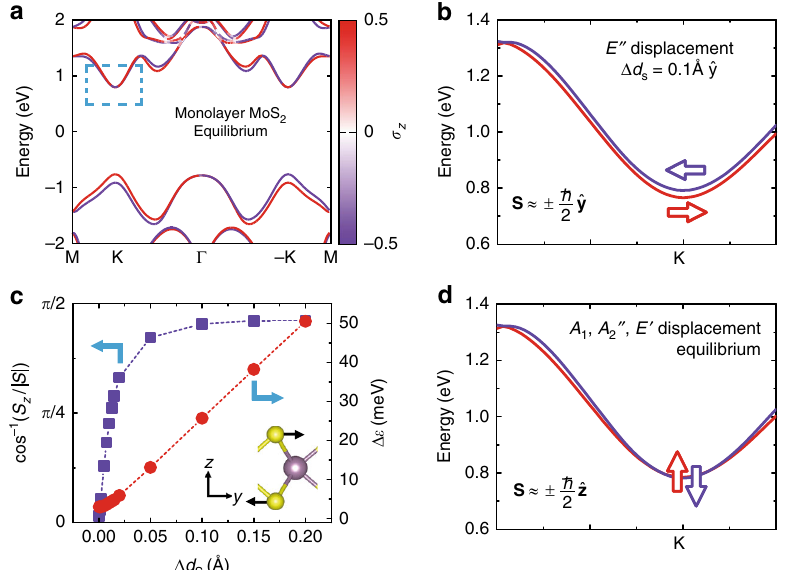
Fig. 2 Electronic structures of monolayer MoS 2 in equilibrium geometry and with the displacement along a speci fi c coherent phonon mode. a The band structure with the equilibrium geometry. b Zoomed-in view of the CBM near the K valley with a displacement along E ″ . c The variations in the inclination of the spin angle and the up/down splitting ( Δ ε gap ) with respect to the magnitude of the displacement along the E ″ phonon mode. d Zoomed-in view of the CBM near the K valley with the equilibrium geometry and with the displacement along the other three zone-center phonon modes E ′ , A 1 , A 2 ″ . In b , d the displacement vectors are normalized such that the maximum shift of the atomic position is 0.1 Å. The dashed box in a indicates the window for the zoom in b and d . Inset in c depicts the direction of the atomic displacement in y direction. Further details of the role of the E ″ phonon mode are given